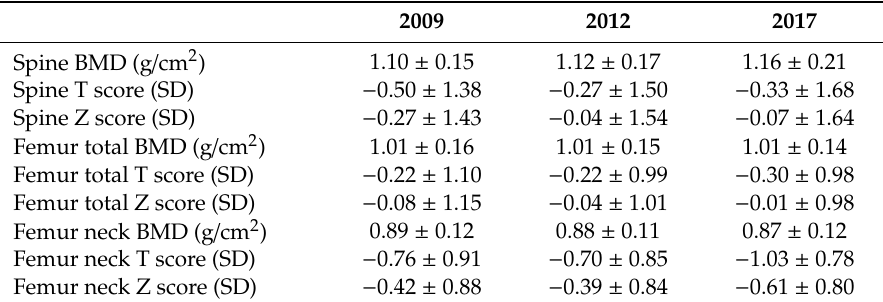
Table 3. Densitometric data of SCD